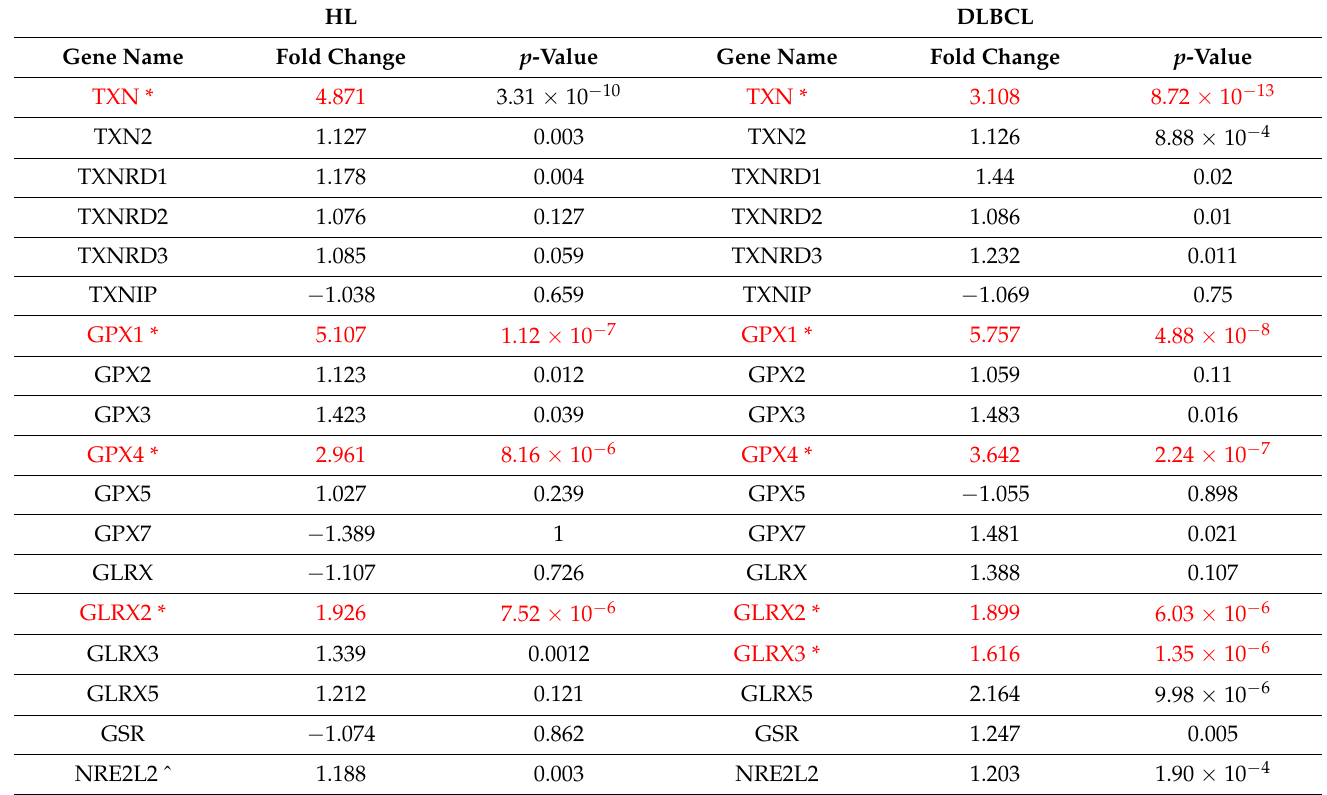
Table 2. Lymphoma cells have up-regulated antioxidant gene expression. mRNA expression in Hodgkin’s lymphoma (HL) and diffuse large B-cell lymphoma (DLBCL) patient samples compared to healthy cells using the Brune lymphoma dataset in Oncomine database [40]. Data was analysed by t -test. n =